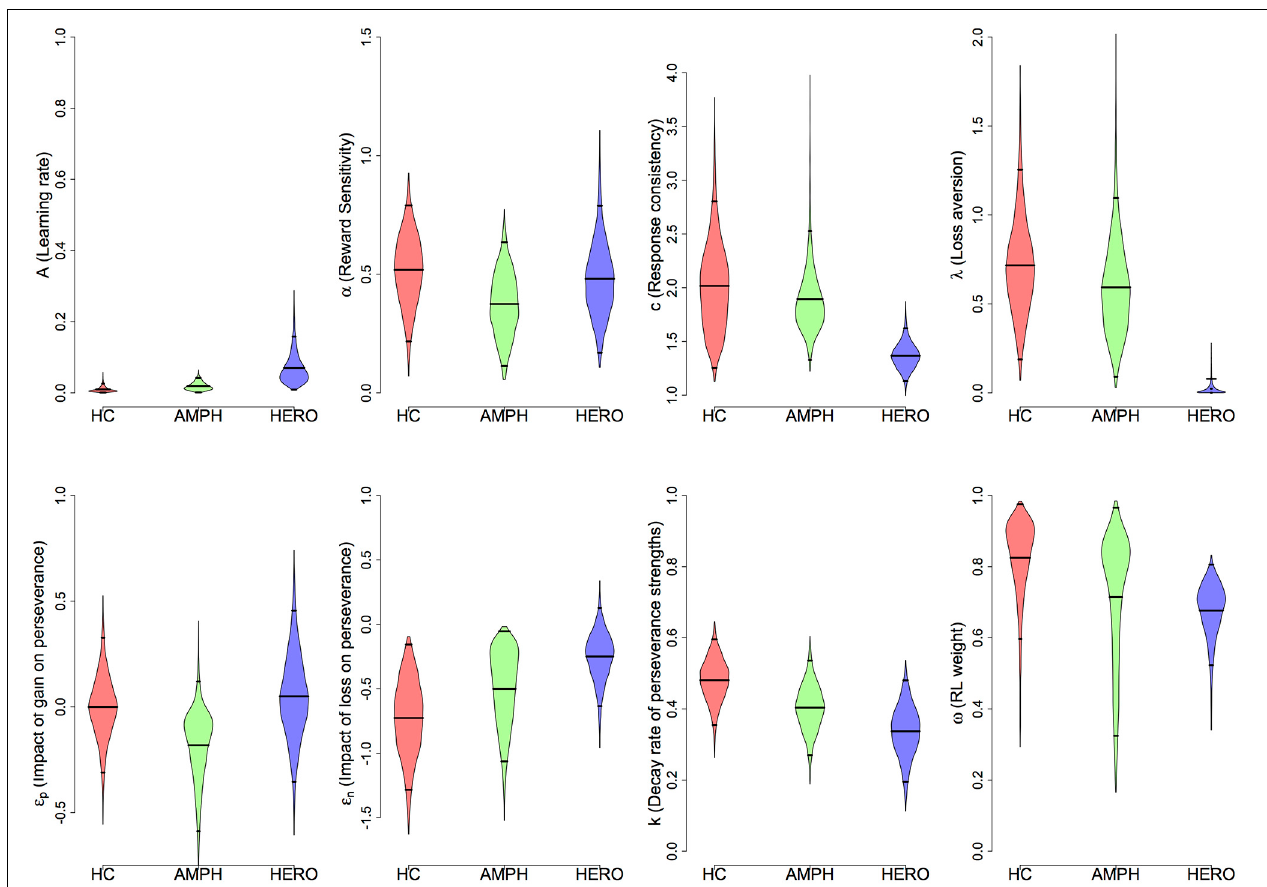
FIGURE 2 | Density plots of posterior group parameter distributions with the Value-Plus-Perseverance (VPP) model. Bottom and top tick marks indicate HDI 95% range, and middle tick marks indicate mean